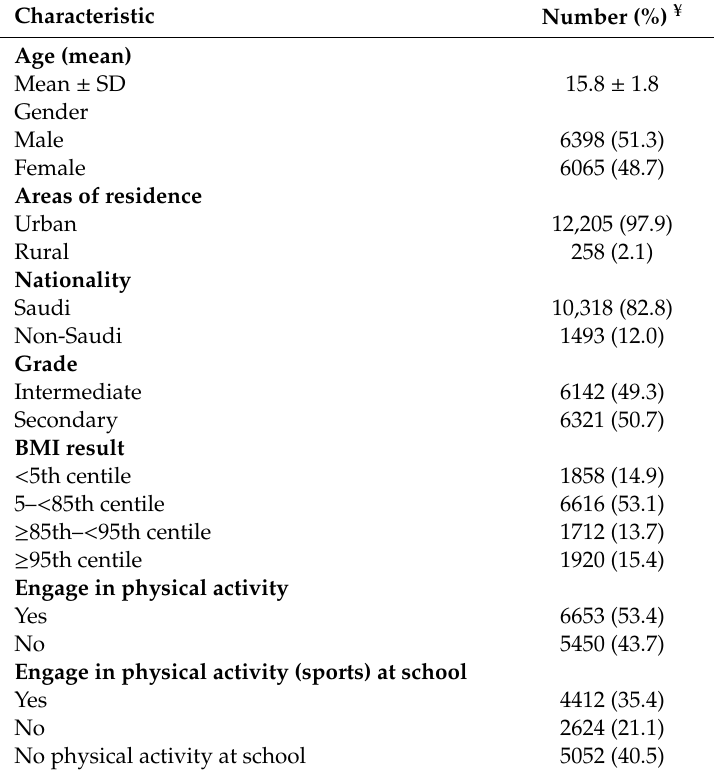
Table 1. Characteristics of the participants ( n =